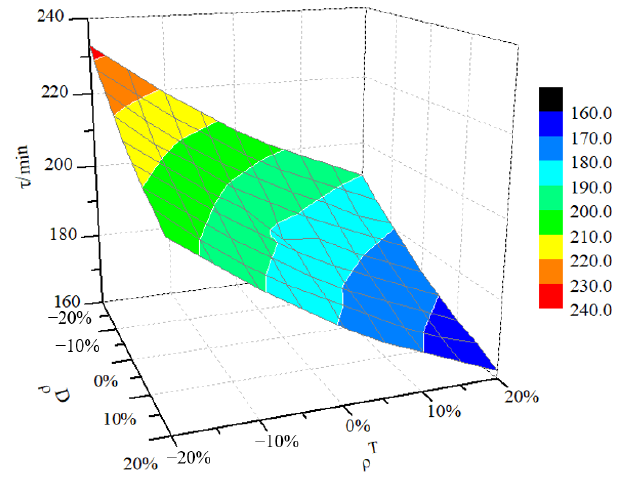
Figure 7. Sensitivity analysis of truck speed and drone speed.